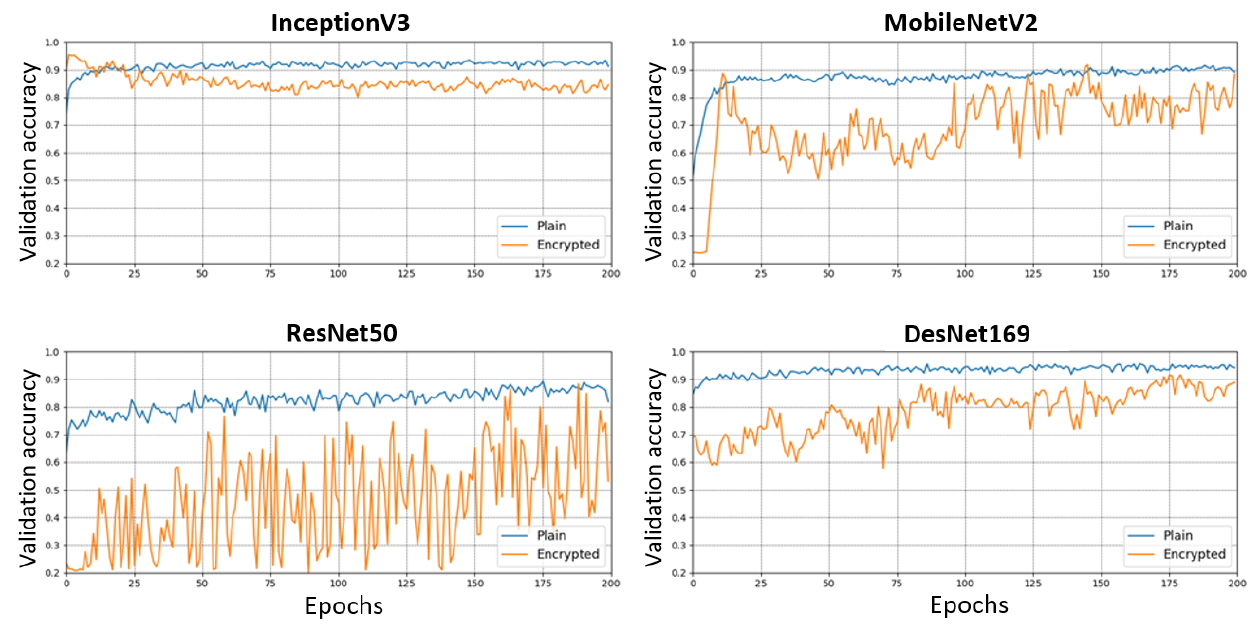
Figure 9. Evolution of the validation accuracy during training on plain and encrypted images for the 4 CNN